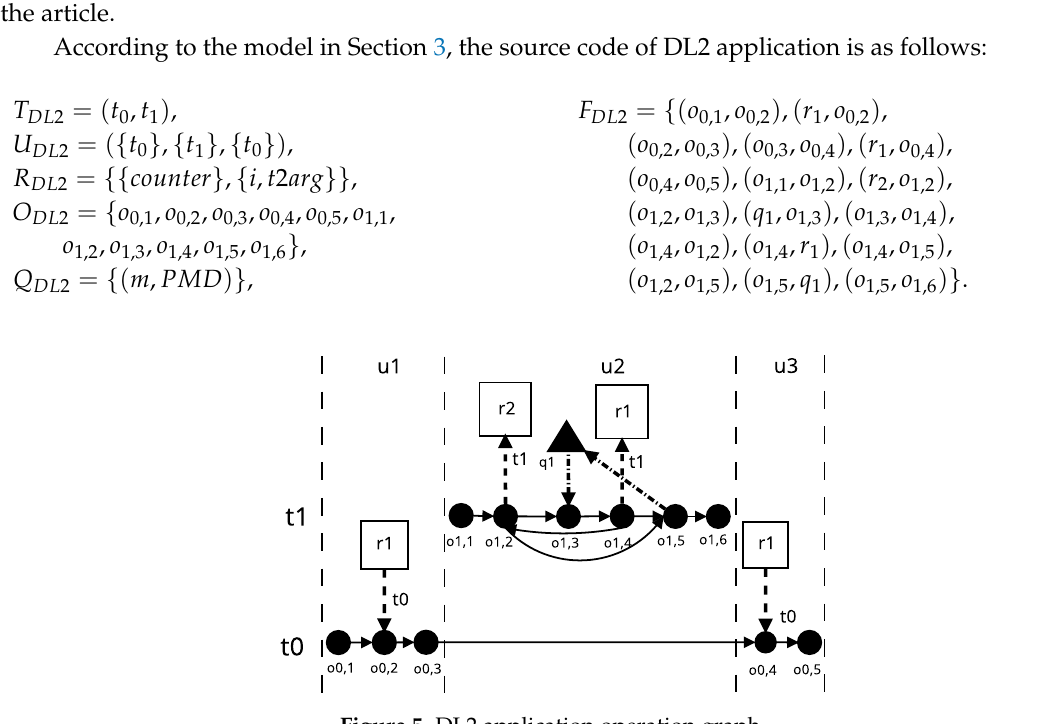
Figure 5. DL2 application operation